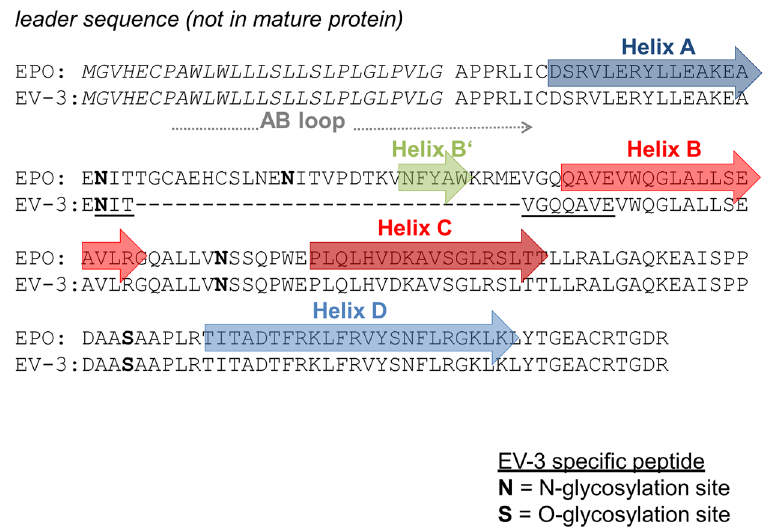
Figure 3. Depiction of the EV-3 specific peptide used for nano-LC-ESI-MS/MS analysis. According to the obtained sequence of the two EPO -PCR amplification products from human adult kidney and foetal brain, aminoacid sequences of EPO and hEPO Δ 3 derived protein EV-3 differ only by 29 aminoacids. The deleted region contains one N-glycosylation site and the AB loop including the minihelix B’. The underlined amino acids in the EV-3 sequence represent the EV-3 specific peptide used in nano-LC-ESI-MS/MS. The representation of EPO’s primary structure is taken from Boissel et al . 84